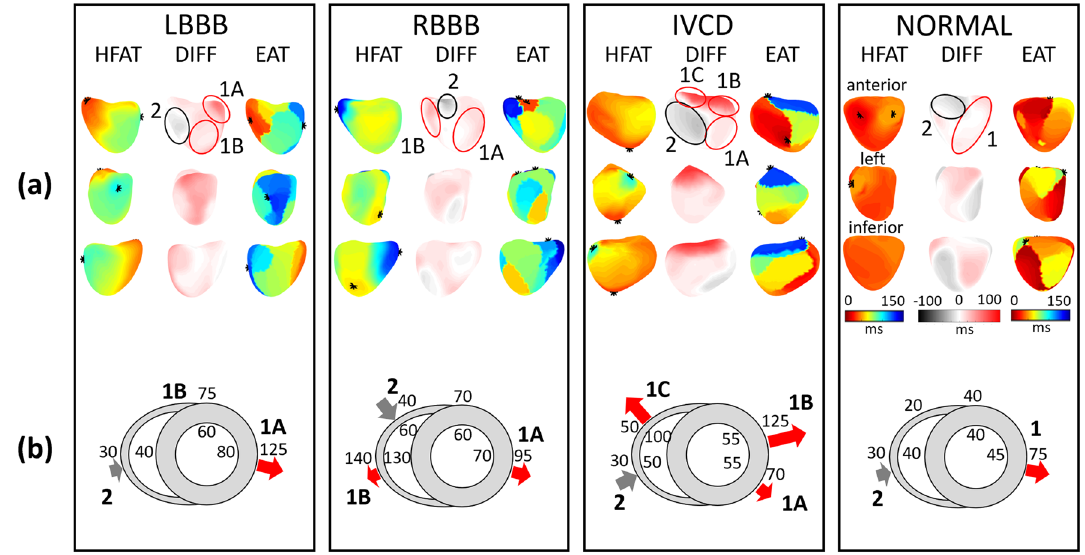
Figure 5. Three-dimensional activation pattern interpretation. High-frequency activation times (HFAT), epicardial activation times (EAT), and differences (DIFF) in four exemplary patients: Left bundle branch block (LBBB, patient #3), right bundle branch block (RBBB, patient #14), intraventricular conduction disturbance (IVCD, patient #1) and normal synchronous heart (NORMAL, patient #11). ( a ) HFAT, DIFF, and EAT maps. Each map is shown from three projections (anterior, left, and inferior). ( b ) The red and gray arrows indicate the direction of electrical activation propagation derived from the EAT-HFAT plot in the second row; the size of the arrow corresponds to the endo-epi time delay. Numbers show the approximate timing of electrical